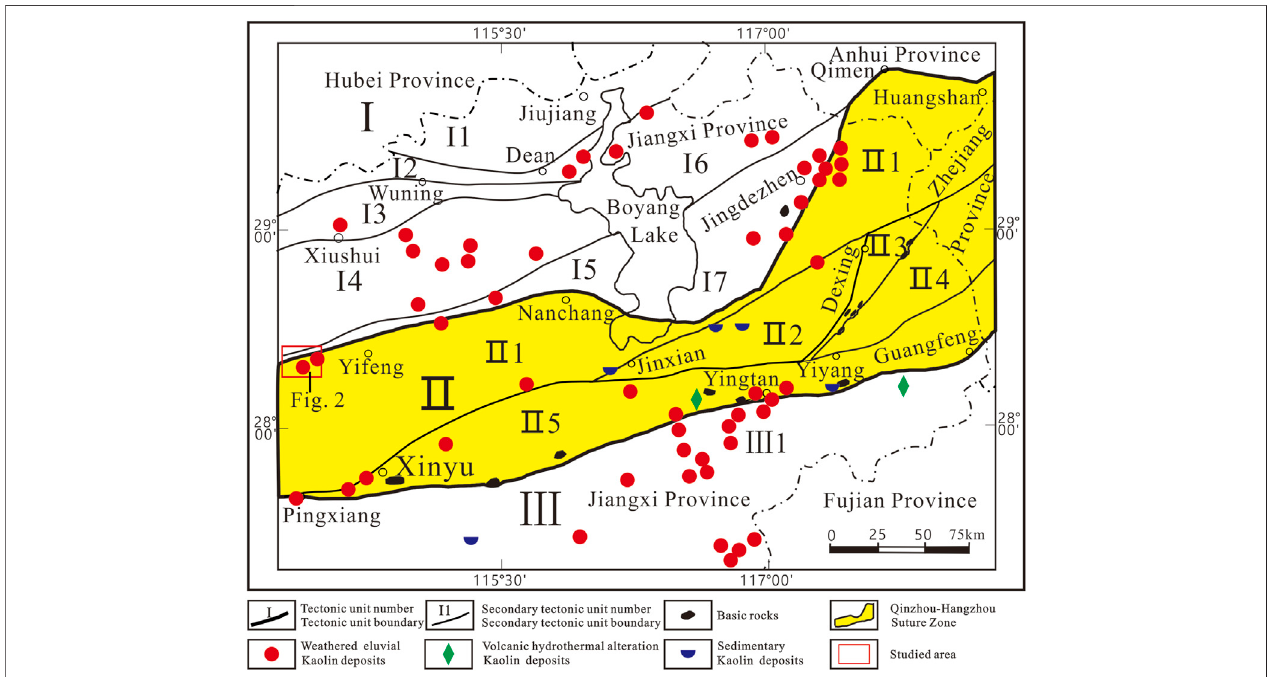
FIGURE 1 | Distribution of Kaolin deposits and the tectonic location in northern Jiangxi province (after Wang et al., 1986 and Jiang et al., 2015).